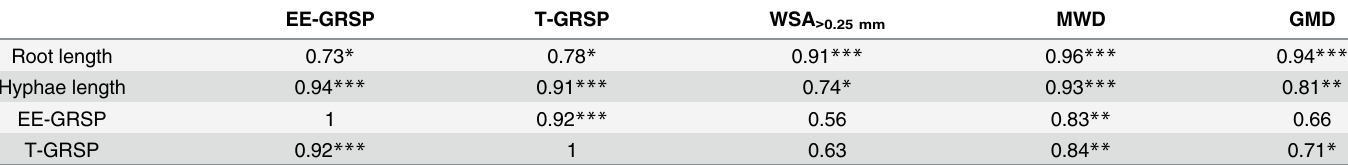
Table 5. Correlation coefficients among variables involved in GRSP content and soil